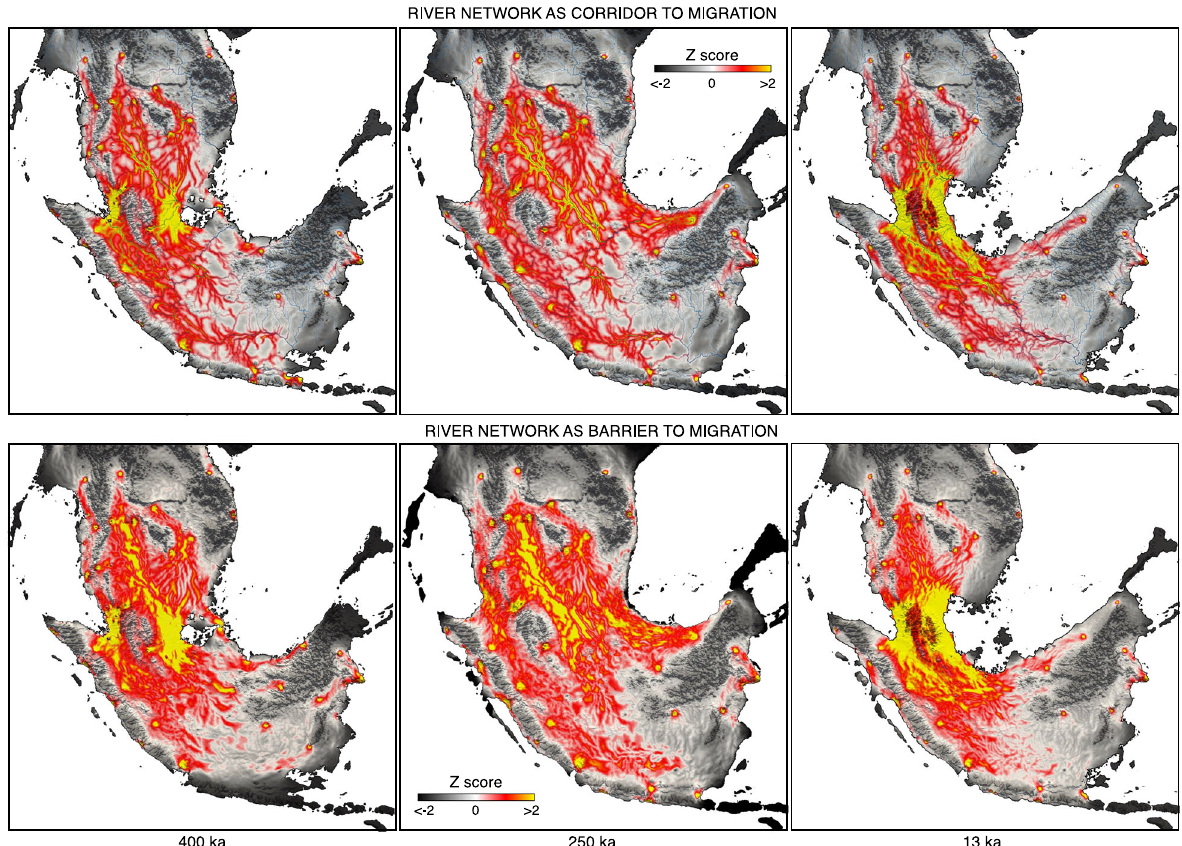
Fig. 5 Regional distribution of current fl ows highlighting connected regions at different time intervals for rivers network considered as corridor or barrier to migration. Cost surfaces combining landscape elevational connectivity, distance to the main river and local slope are used to compute current fl ow fi elds 35 . Current fl ow values are then standardised at each time step by calculating z-scores to evaluate temporal changes in landscape connectivity across the different maps. Positive z-scores (red to yellow) represent high connectivity areas acting as preferential pathways across the Sunda